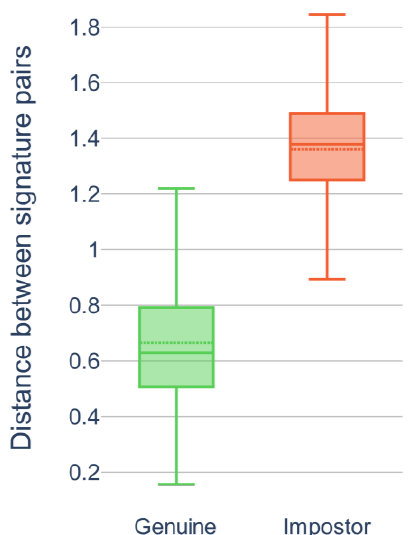
Figure 12. “ Genuine ” histogram shows the distribution of distances for pairs of signatures belonging to a single person, while “ Impostor ” depicts the distance distribution for pairs of signatures of different clients.